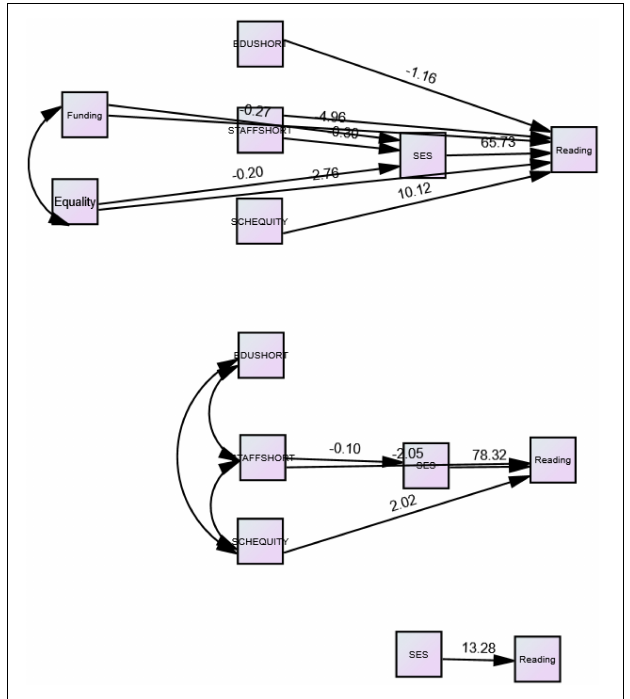
FIGURE 4 | Partial mediation model for reading with parameter